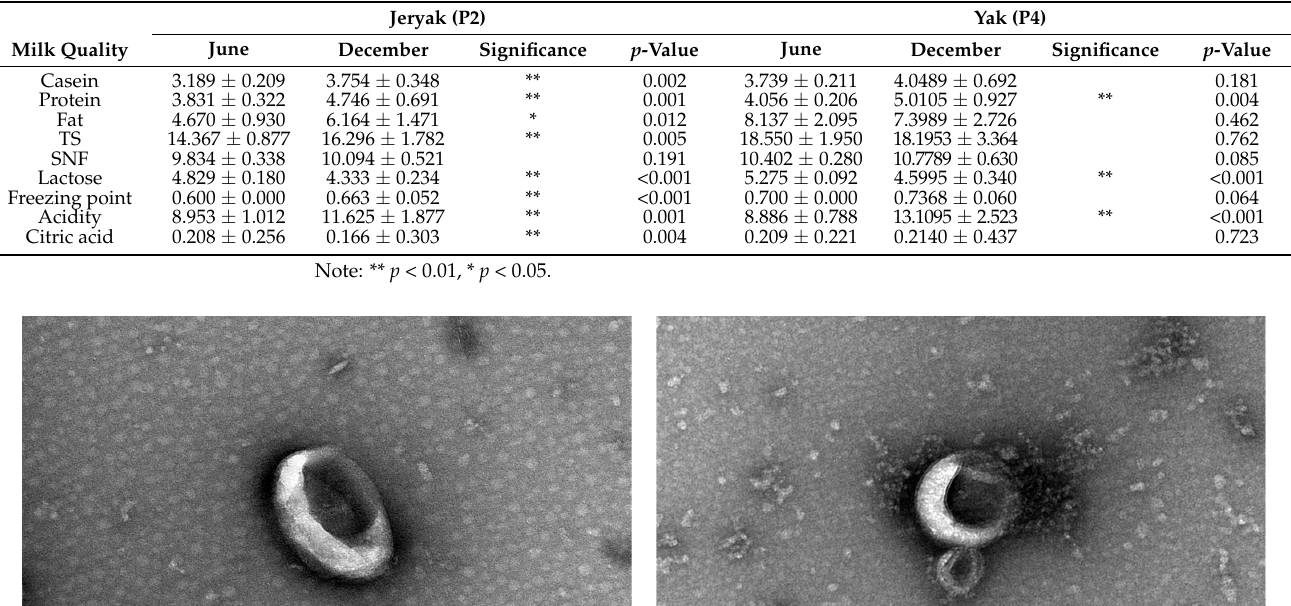
Table 2. Comparison between the quality of milk sampled in June and December from Jeryak milk (P2: Jeryak in June vs. Jeryak in December) and Yak milk (P4: Yak in June vs. Yak in December).